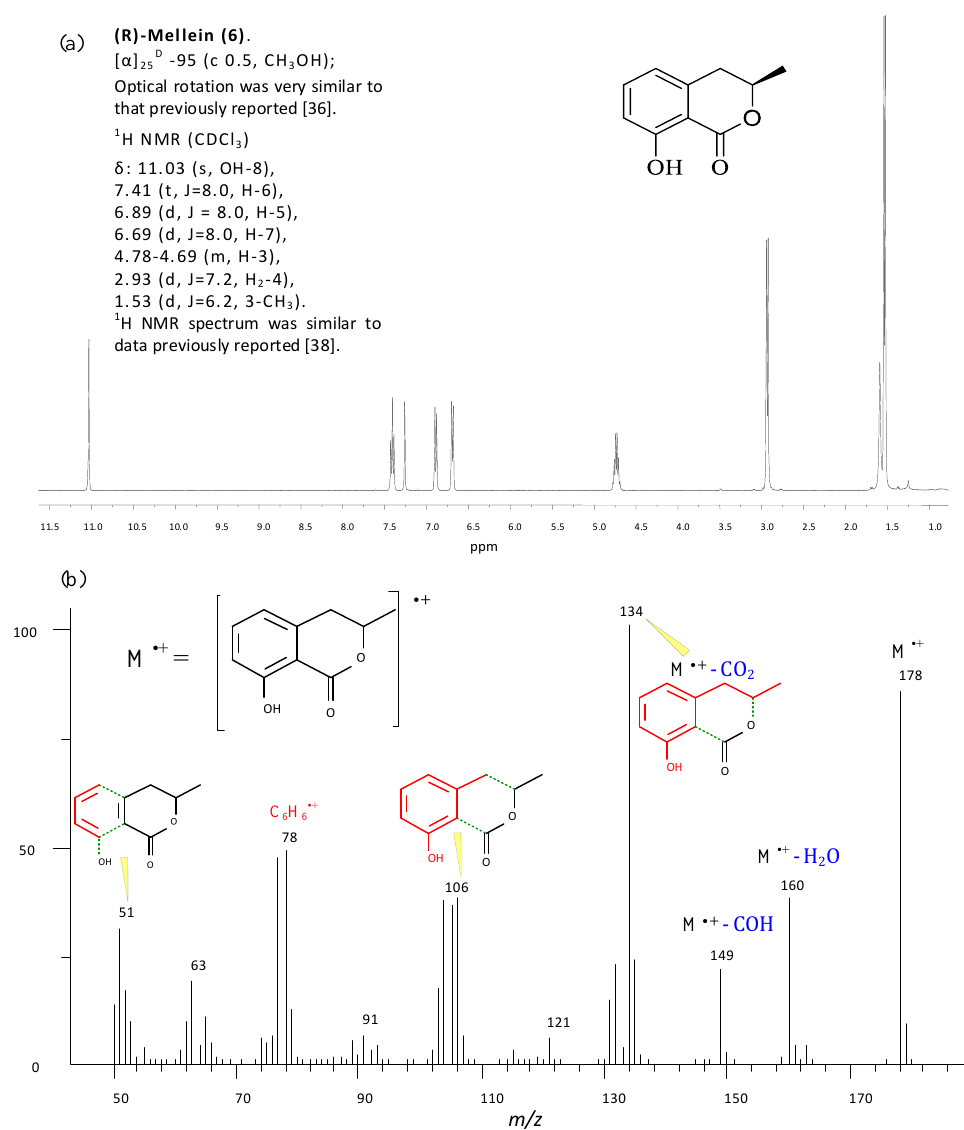
Figure 7. ( a ) 1 H NMR spectrum of ( R )-mellein ( 6 ) recorded at 400 MHz in CDCl 3 ; ( b ) 70 eV EI mass spectrum of mellein (ionic fragments are colored in red and neutral losses from the molecular ion, M + , are colored in blue).